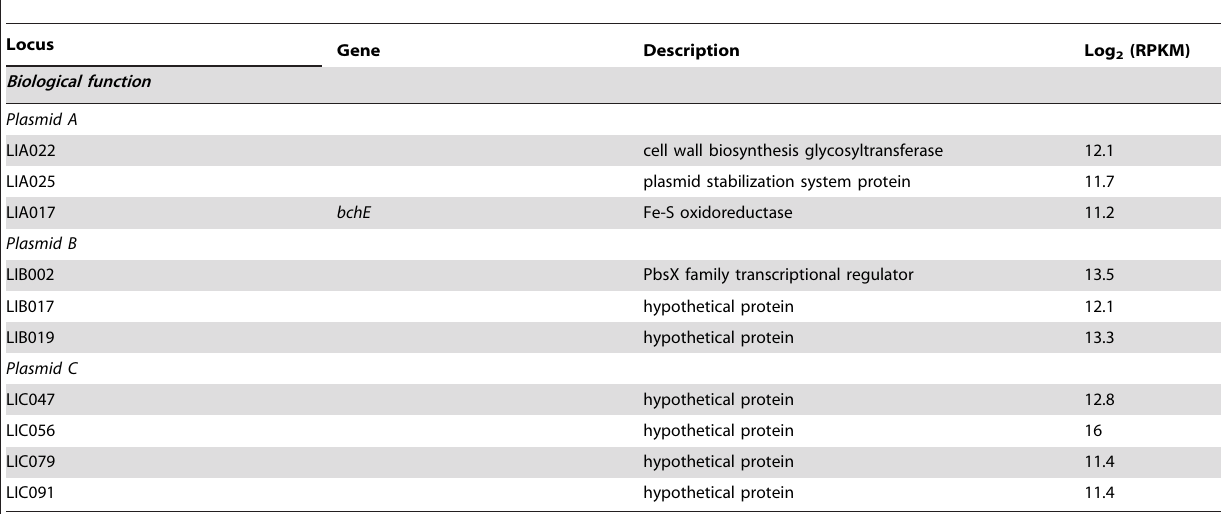
Table 3. Plasmid-encoded genes with highest transcript levels exclusively expressed by the pathogenic variant of the L. intracellularis isolate